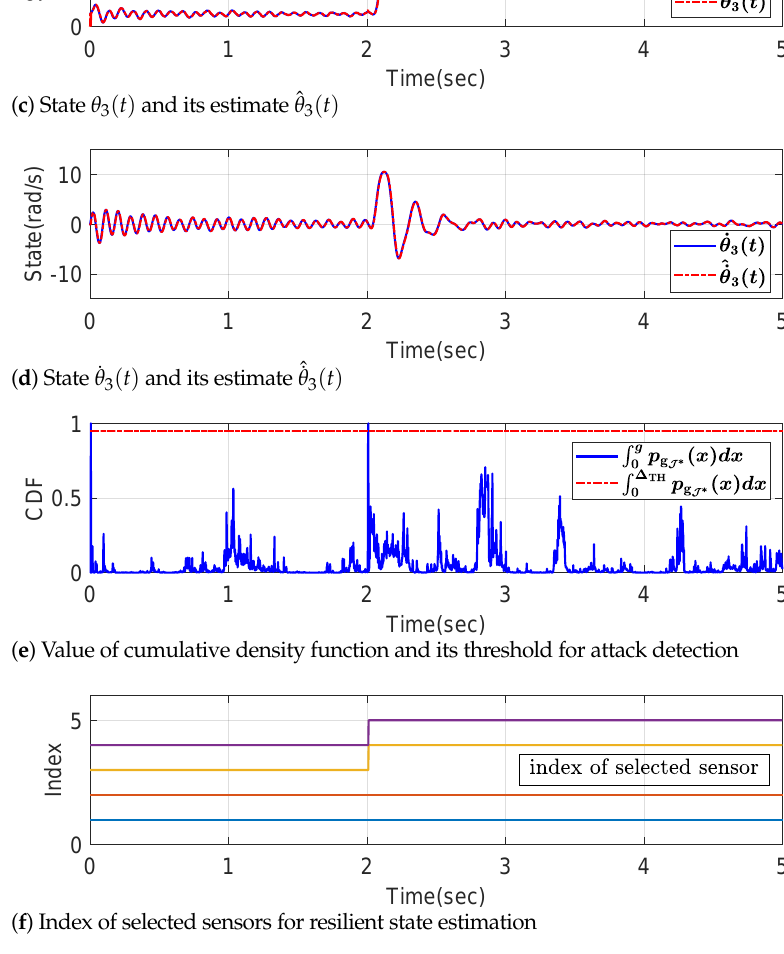
Figure 4. Plot of signals in a multi-DOF torsion